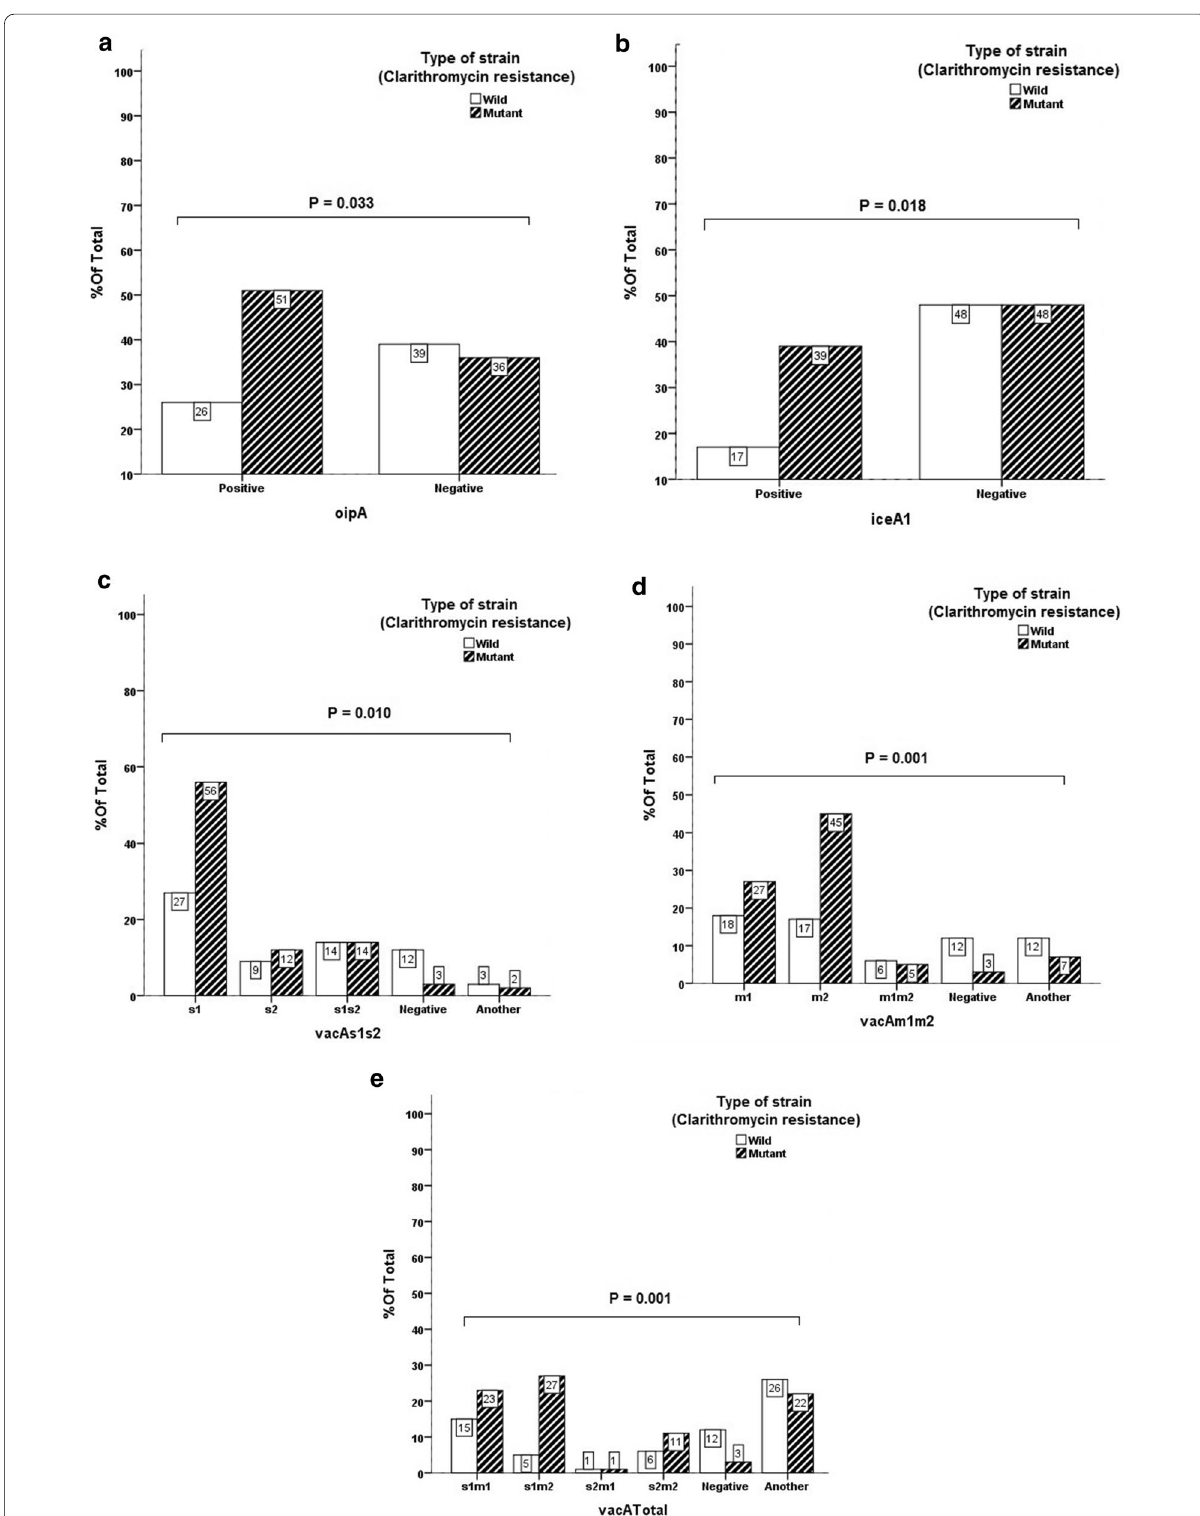
Fig. 1 Correlation between the presence of virulence genes, oipA ( a ), iceA1 ( b ), vacAs1s2 ( c ), vacAm1m2 ( d ), vacATotal ( e ) and antibiotic